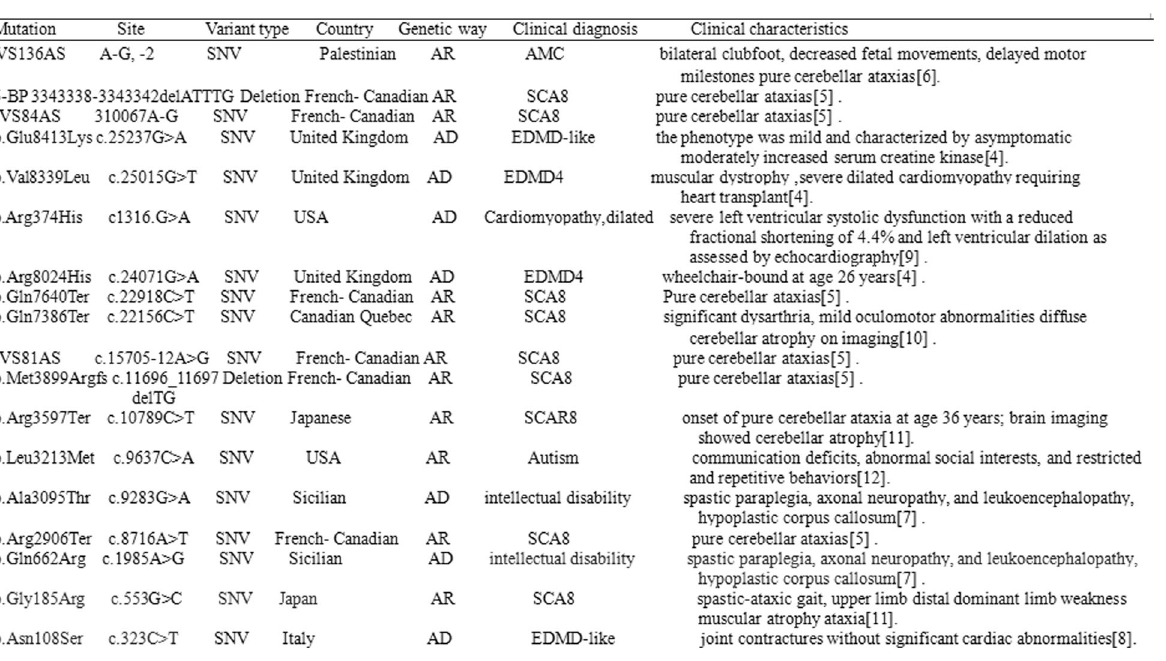
Fig. 7 Clinical features of reported SYNE1 mutations in the all word. SNV: single nucleotide variant; AMC : Arthrogryposis multiplex congenita ; EDMD4: Emery-Dreifuss muscular dystrophy 4; SCA8: Spinocerebellar ataxia8; [4]: References [4 – 7, 9 –